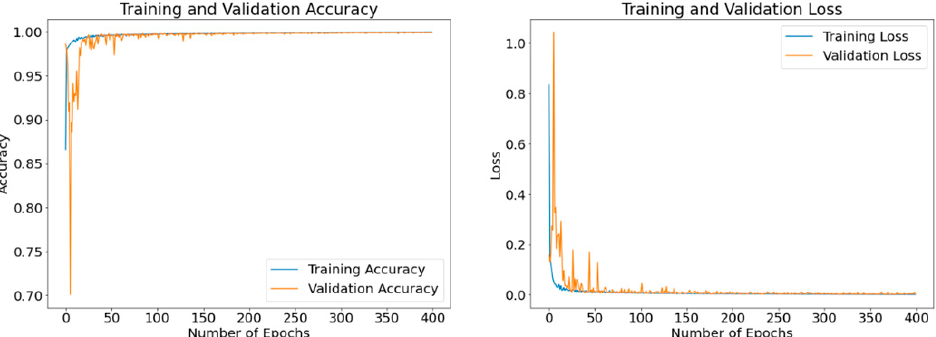
Figure 17. Accuracy and loss curves generated by RMSProp optimizer after model training (blue) and validation (orange) using a batch size of 32 samples and up to 400 epochs.